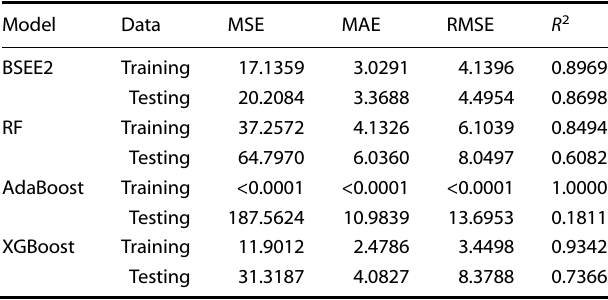
Table 5. Comparison of regression effects of various